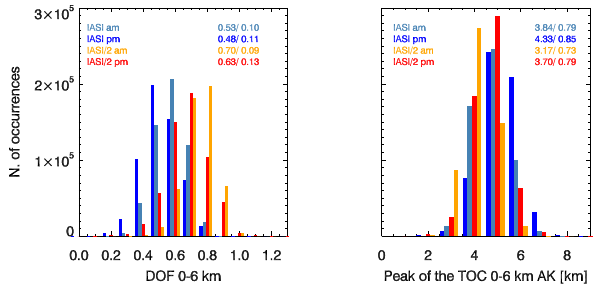
Fig. 4. Histogram of the DOF surface–6km (left) and of the alti- tudes of the maximum of the integral AK for the surface–6km TOC (right), for AM and PM overpasses, for IASI (sky blue and blue) and IASI/2 (orange and red). Mean values and standard deviations are also reported in the upper right corners (mean/std). The data cover the whole period of study (August